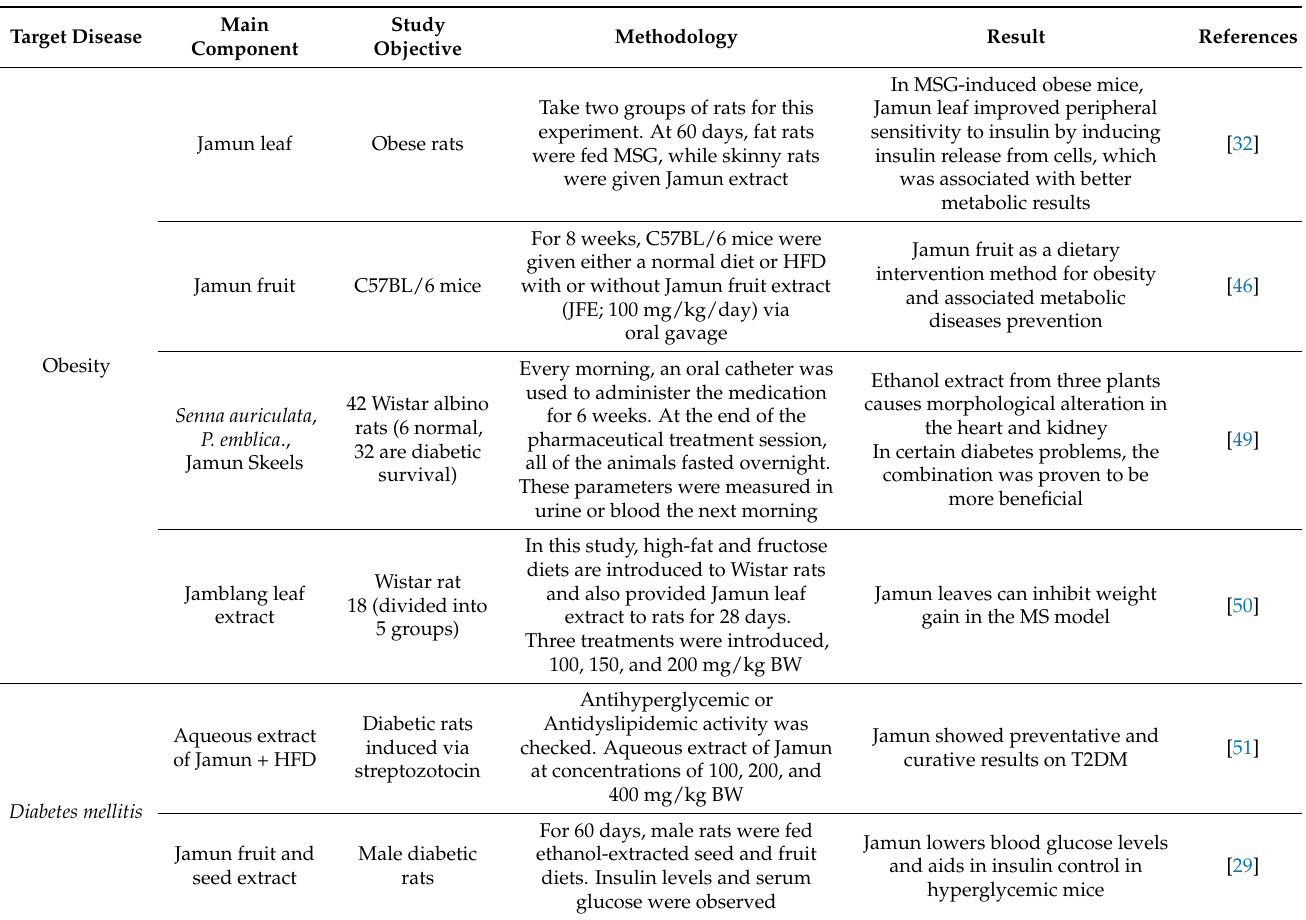
Table 3. Therapeutic effects of